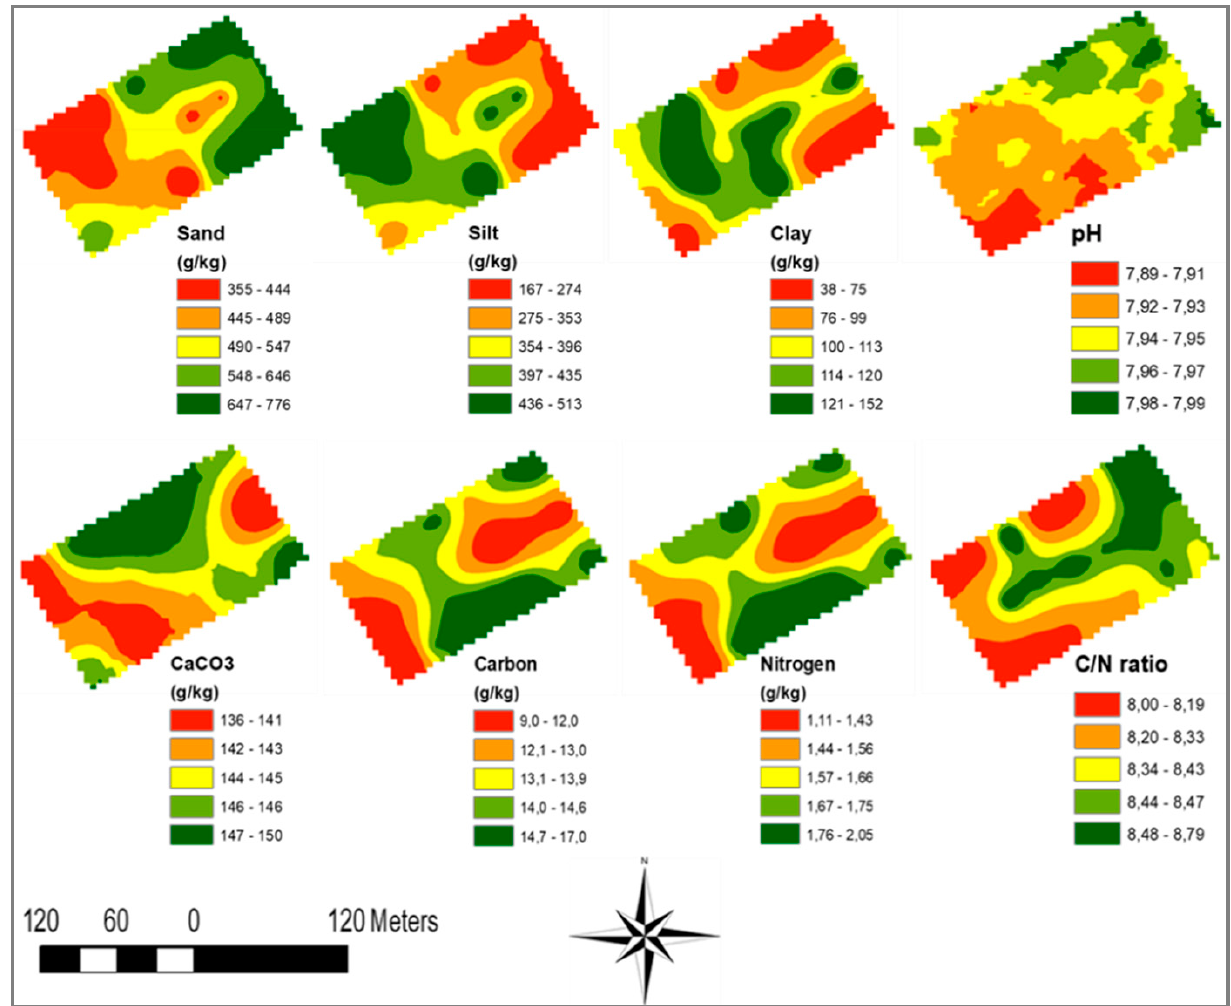
Figure 4. Spatial variability of soil traits ( n = 937). 3.3. NDVI Indices: Descriptive Statistics, Relationships with Yield, Spatial Variability,